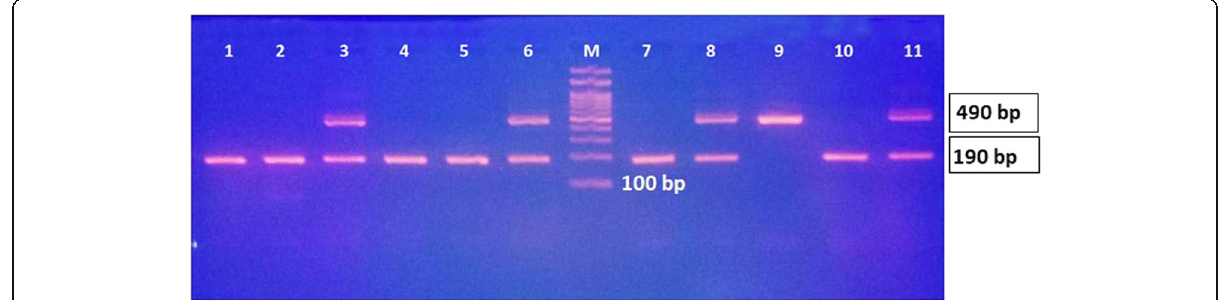
Fig. 1 Gel electrophoresis of ACE ID gene polymorphism amplified with a specific pair of primers using conventional PCR. The PCR products were stained with ethidium bromide. Lanes 1, 2, 4, 5, 7, and 10: homozygous DD genotypes; lanes 3, 6, 8, and 11: heterozygous ID genotypes; lane